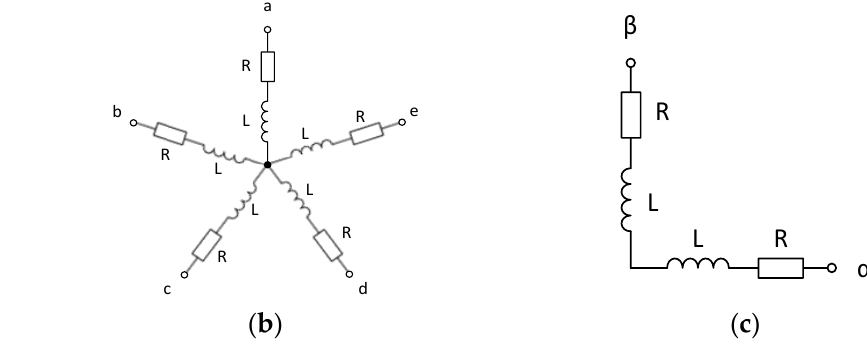
Figure 5. The basic scheme of the considered linear RL load for 3- ( a ), 5- ( b ), and 2- ( c ) phase systems.